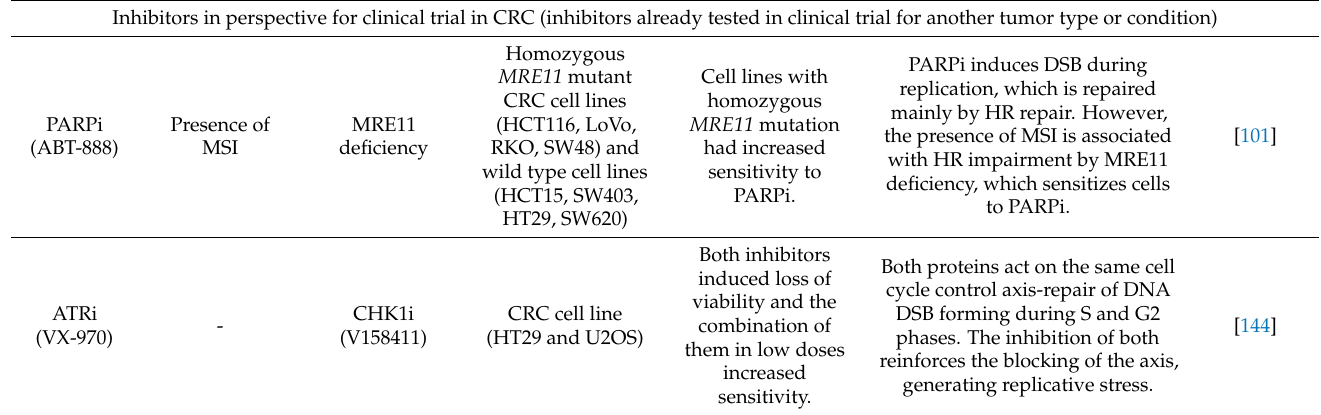
Table 1. Proteins related to replicative stress and DSB processing: situation of inhibitor studies (in vitro) and relevant biomarkers.